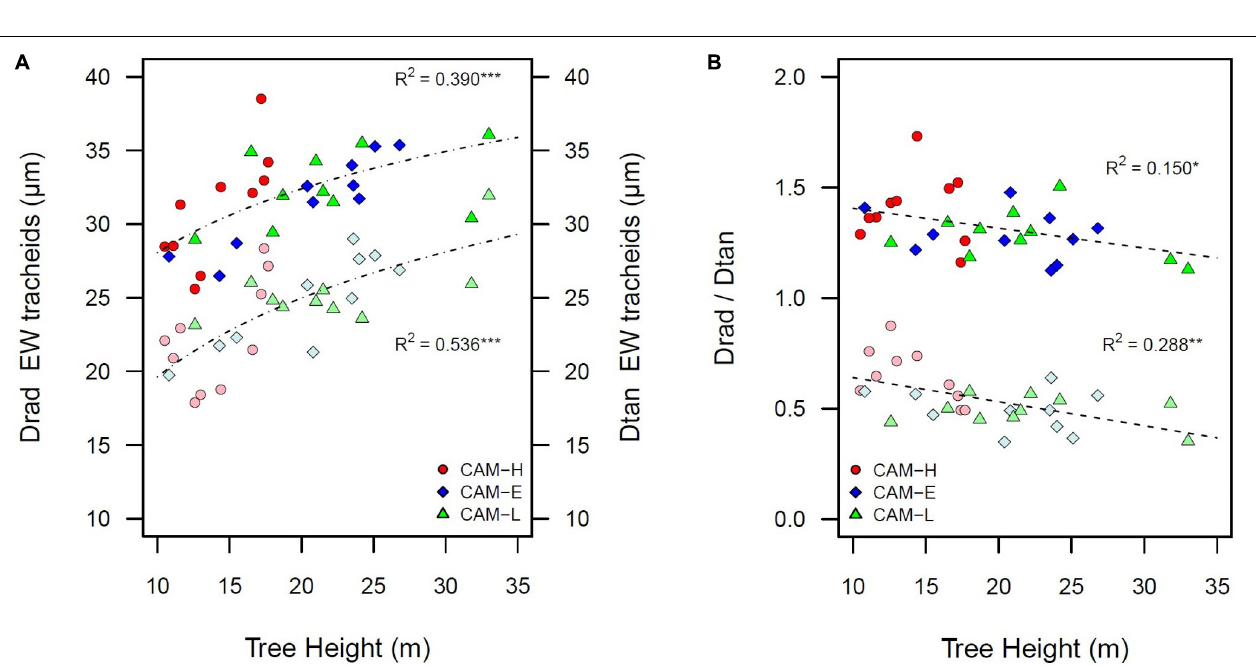
FIGURE 3 | (A) Radial diameter (Drad) of EW tracheid lumen in bright color, and tangential diameter (Dtan) of EW tracheid lumen in pale color as a function of tree height. (B) Negative relationship between the ratio of radial and tangential diameter of tracheid lumen (Drad/Dtan) and tree height in bright color for EW portion and in pale color for the LW portion. The data shown are for the last year (2012). Each symbol (circle, diamond, and triangle) corresponds to a tree from the three plots CAM-H (red), CAM-E (blue), and CAM-L (green). All relationships are significant (* P < 0.05, ** P < 0.01, *** P < 0.001).